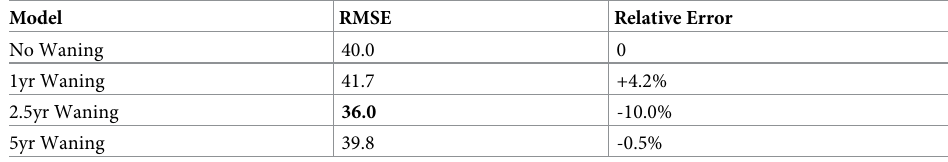
Table 3. RMSE and relative error of models with and without waning of immunity, from July 27 th , 2021 to Sept. 16 th , 2021 (delta wave